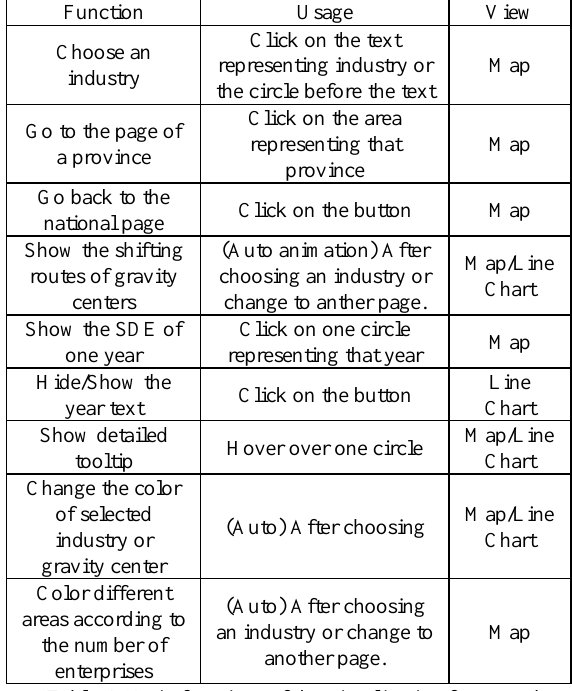
Table 4. Main functions of the visualization